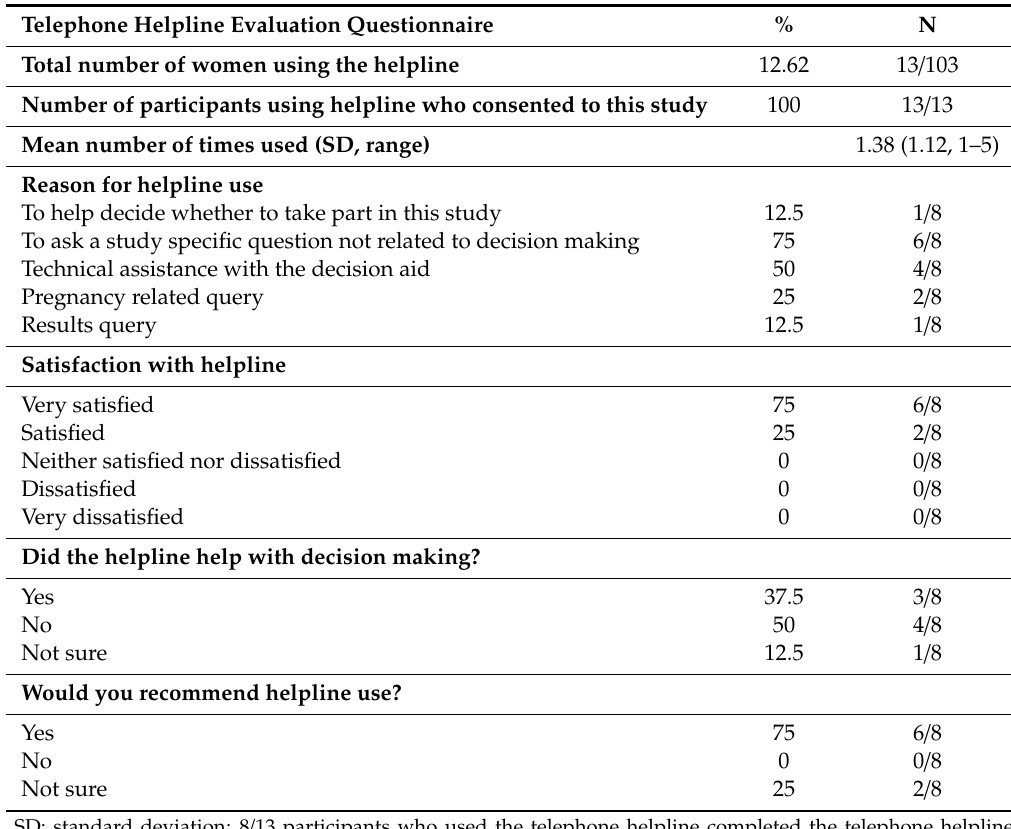
Table 3. Telephone helpline evaluation questionnaire responses.